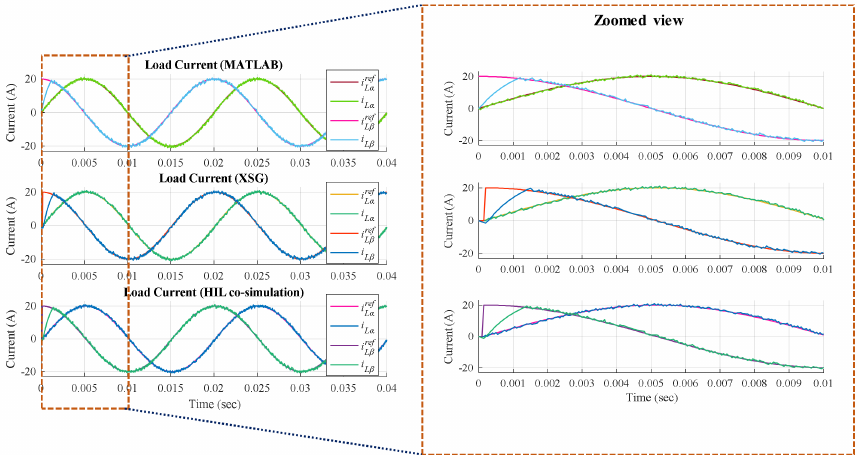
Figure 16. Current tracking for the real and imaginary components of the load current ( i L α and i L β ) obtained using MATLAB/Simulink, XSG, and HIL co-simulation.